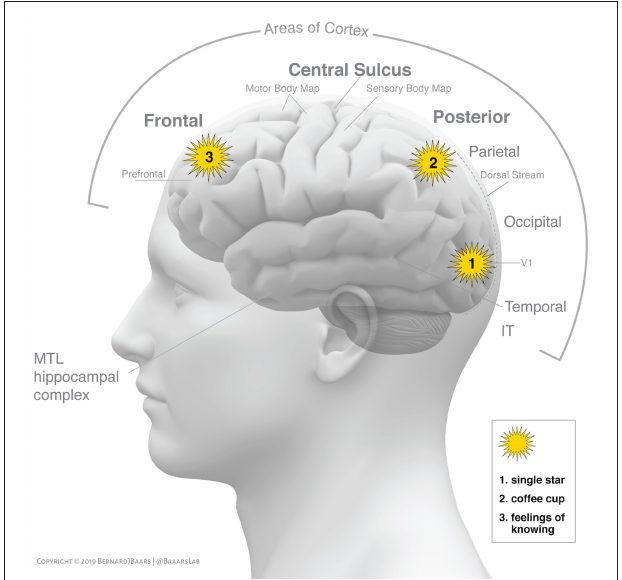
FIGURE 1 | Shows three separate conscious events in a graphic interpretation of alternative sources of “ignition” in the C-T core ( Baars and Geld, 2019, p. 581). All three involve binding and broadcasting (“ignition”) in three cortical locations. Area V1 is the first visual projection area in the cortex, and has the proper resolution and contrast representation to resolve the light from a single star on a dark night. Parietal cortex serves to contextualize conscious objects in egocentric and allocentric space, as in a coffee cup. The third “ignition” is hypothesized to emerge in the prefrontal cortex, plausibly involving a Feeling of Knowing (FOK), such as is induced by a tip-of-the-tongue task. (The hippocampus is not considered here, but it plays a major role in conscious perception and memory formation). Reprinted with